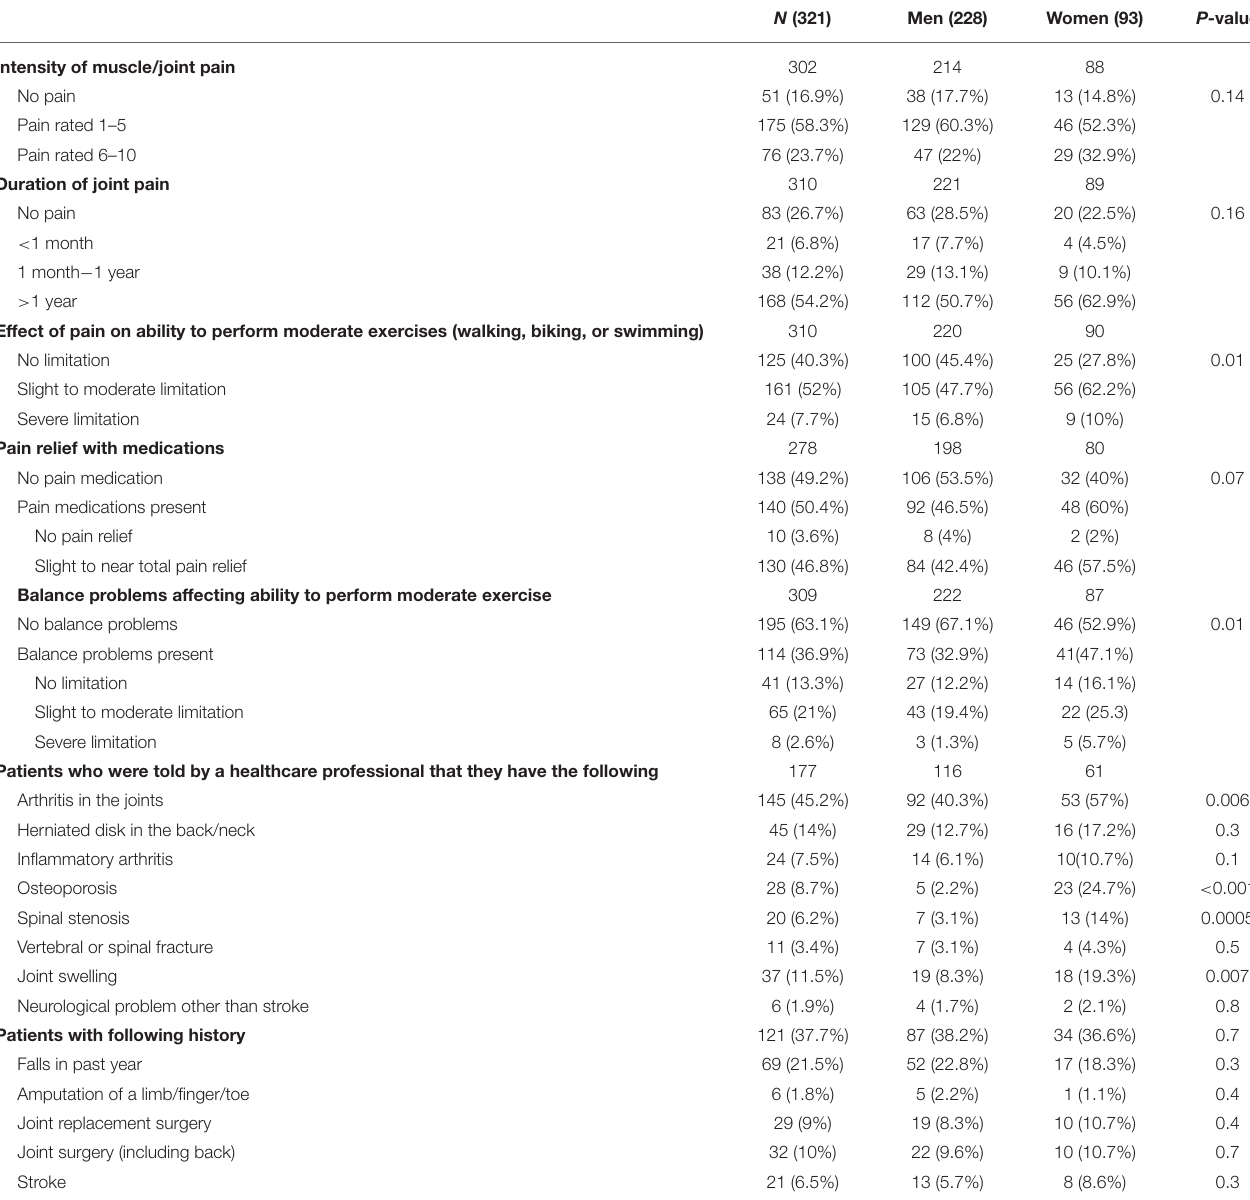
TABLE 2 | Patient distribution according to musculoskeletal limitations screening